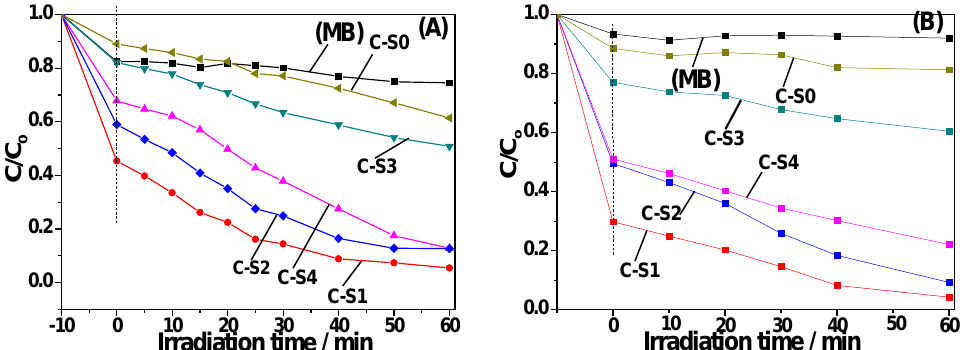
Figure 10. Photocatalytic degradation of MB using the samples ( A ) under UV irradiation and ( B ) under visible light irradiation. Table 1. S BET , total pore volume for C-S1, C-S2, C-S3, C-S4, and C-S0.